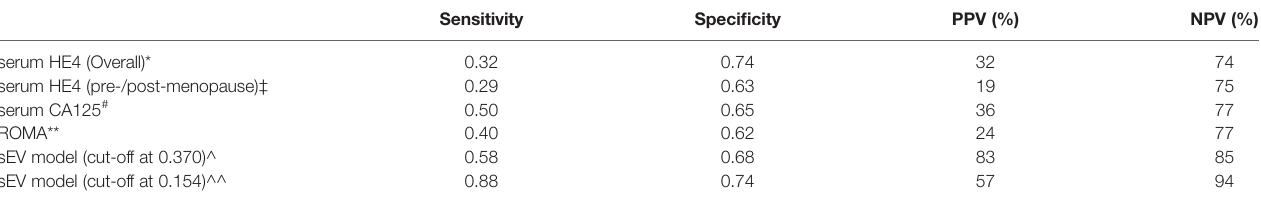
TABLE 6 | The sensitivity and speci fi city of serum markers and sEV model to identify the early stage EOC patients from controls.